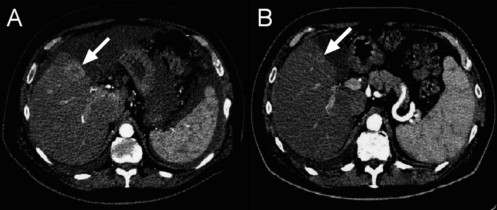
Radiological follow up of hepatic tumor manifestations. MS- CT axial: Representative nodule of the diffuse cholangiocarcinoma with marked arterial phase contrast enhancement (A), declining under chemotherapy (B).